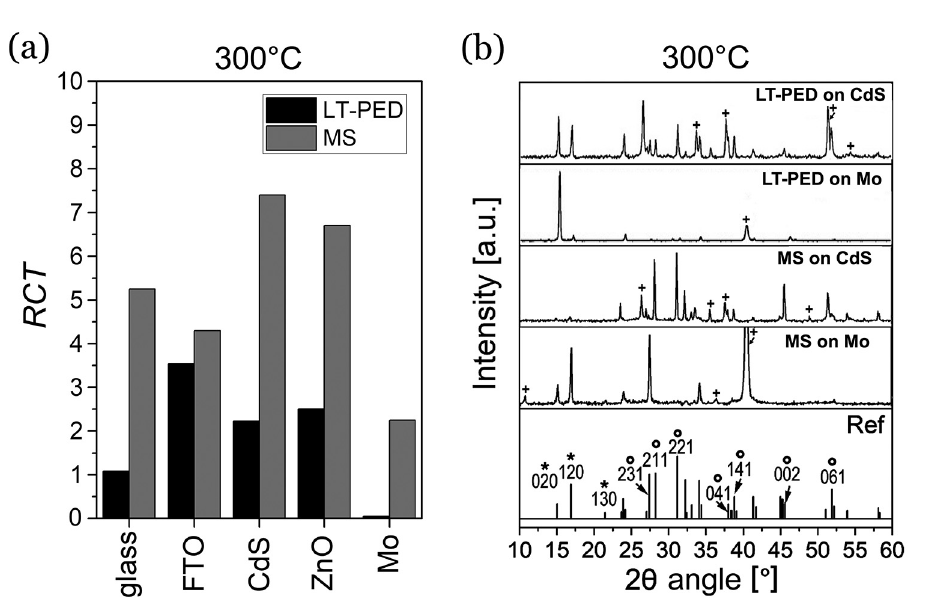
Fig. 3. – (a) RCT values for Sb 2 Se 3 films deposited on different substrates by LT-PED and MS at 300 ◦ C. (b) X-ray diffraction patterns of Sb 2 Se 3 films deposited on Mo and CdS at 300 ◦ C using LT-PED and MS; peaks from the used substrates are marked with + symbol; JPCDS 15–0681 reference is reported at the bottom, where a few selected reflections are highlighted with * symbol, if related to ribbons laying parallel to the substrates, or with ◦ symbol, if related to ribbons with an orientation having a non-zero perpendicular component ( hkl with l (cid:3) =